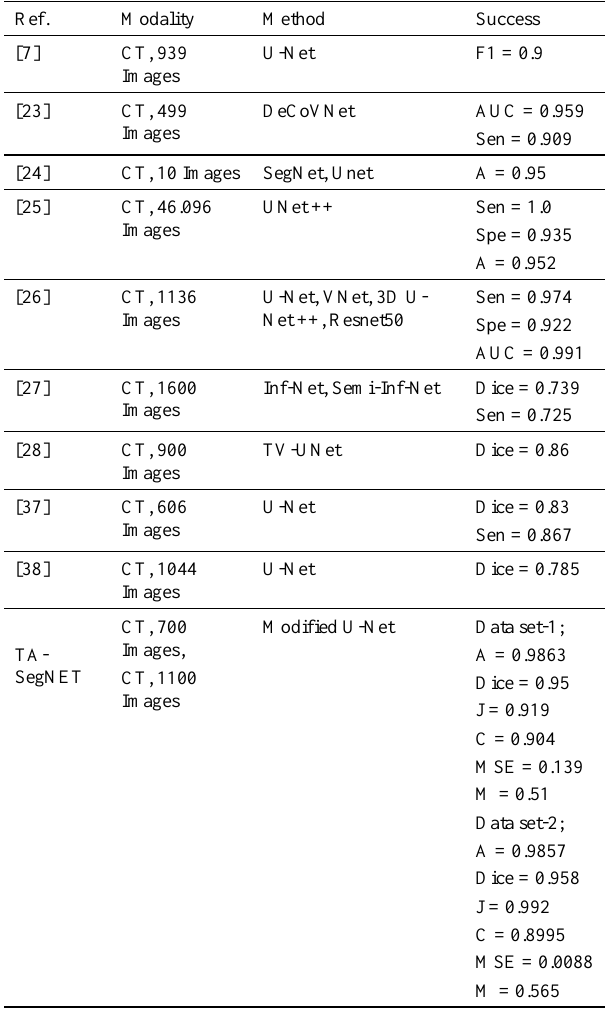
C OMPARISON OF THE O BTAINED R ESULTS WITH THE L